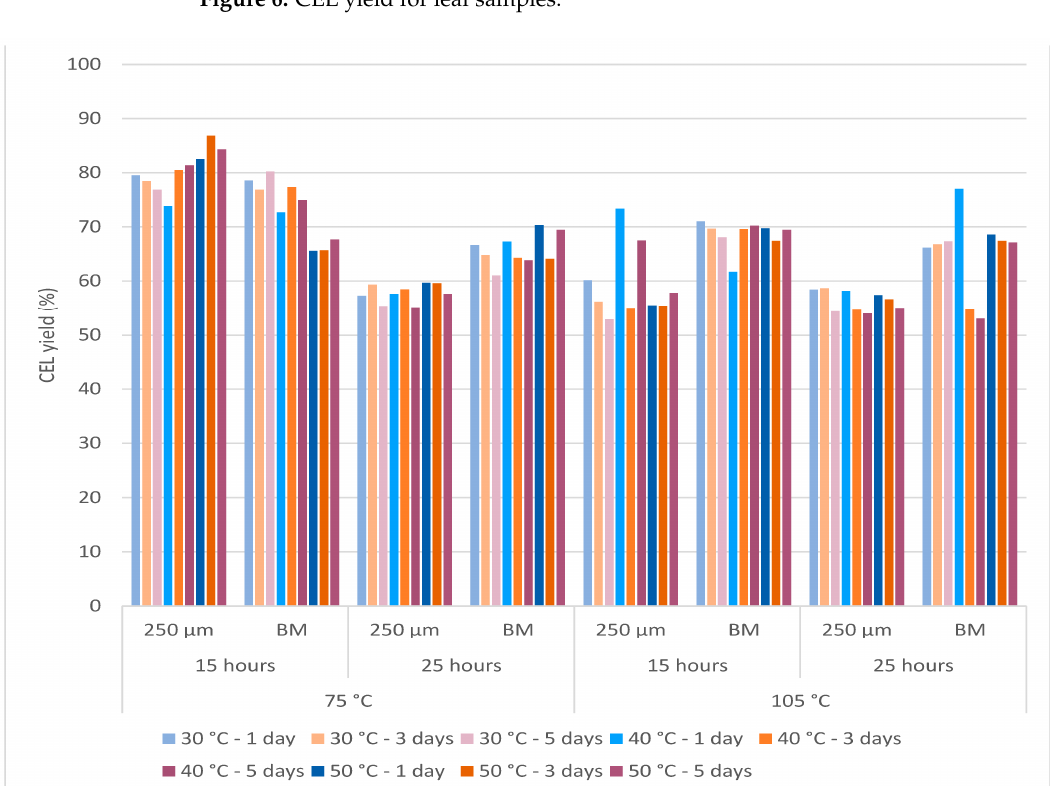
Figure 6. CEL yield for leaf samples.